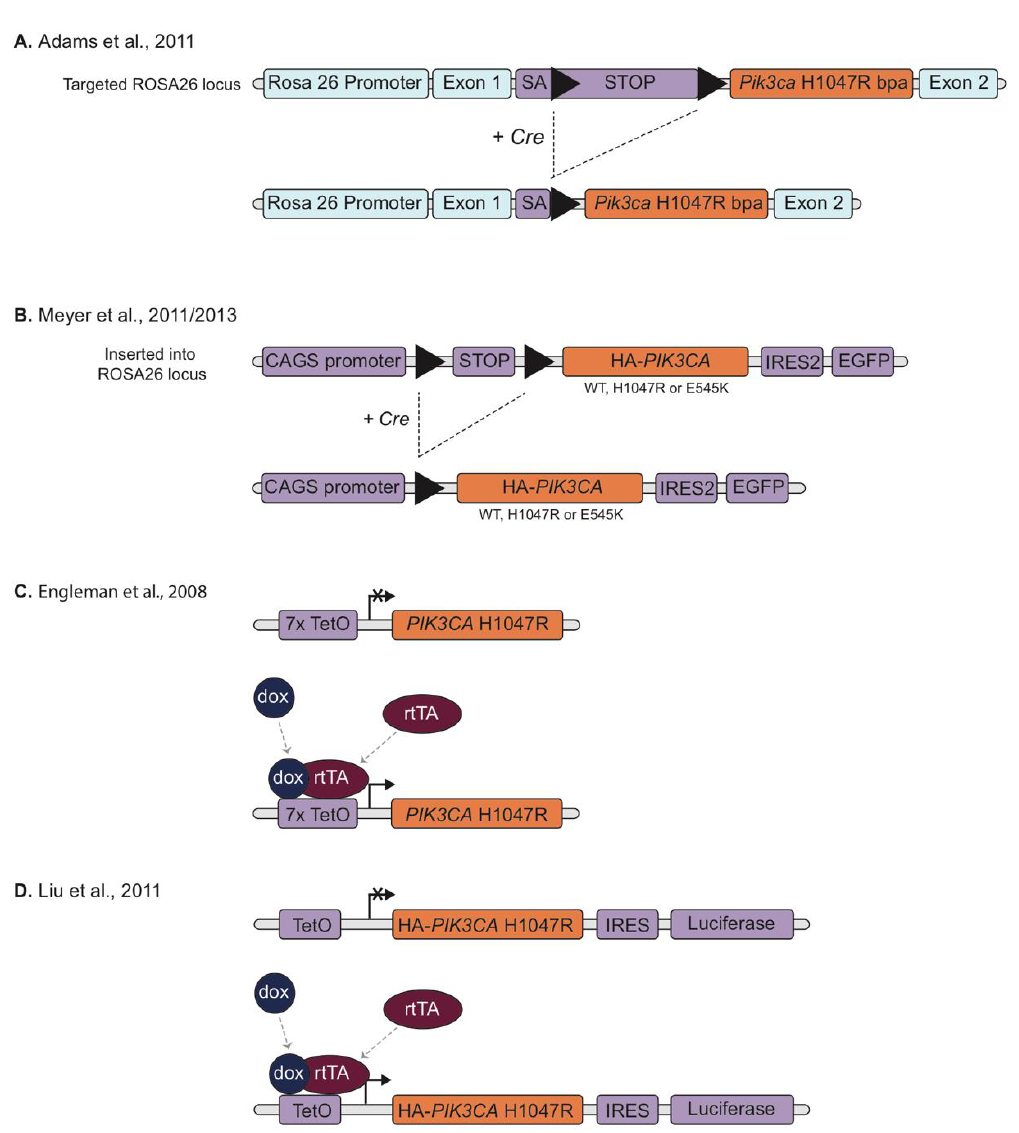
Figure 2. Schematic overviews of Pik3ca mutation specific transgenic models. ( a ) A mouse Pik3ca cDNA (modified to express the H1047R mutation), preceded by a splice acceptor sequence (SA) and a loxP -flanked transcriptional stop cassette (STOP), inserted into the ROSA26 gene locus. Upon expression of Cre recombinase (Cre) the stop cassette is excised allowing expression of mutant Pik3ca under the control of the endogenous ROSA26 promoter [40]. ( b ) A construct with a chicken β -actin (CAGS) promoter and a loxP -STOP- loxP sequence upstream of a 5’-terminally hemagglutinin (HA)-tagged human PIK3CA cDNA (wild type or modified to express H1047R or E545K mutations) and an IRES2-EGFP reporter element (an internal ribosome entry site (IRES) upstream of an enhanced green fluorescent protein (EGFP) cDNA), inserted into the ROSA26 locus. Expression of Cre recombinase results in the excision of the stop cassette allowing CAGS promoter-driven expression of the Pik3ca cDNAs and the green fluorescent protein (GFP) reporter [44,64]. ( c ) A DNA transgene consisting of seven direct repeats of the tetracycline operator (TetO) sequence followed by human PIK3CA cDNA containing a H1047R mutation. Reversible expression of the transgene requires the expression of a reverse tetracycline transactivator protein (rtTA) and is controlled by the administration of doxycycline (dox) [39]. ( d ) Similar to (C) but includes a downstream IRES and luciferase reporter gene [41]. Triangles represent loxP sites. Blue colour indicates endogenous gene sequence, orange indicates Pik3ca cDNA and purple indicates vector DNA